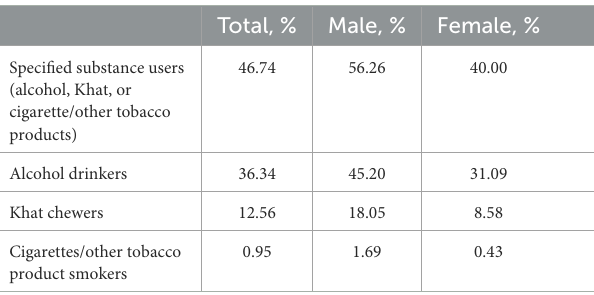
TABLE 3 Model comparison and goodness-of-fit test in the multilevel